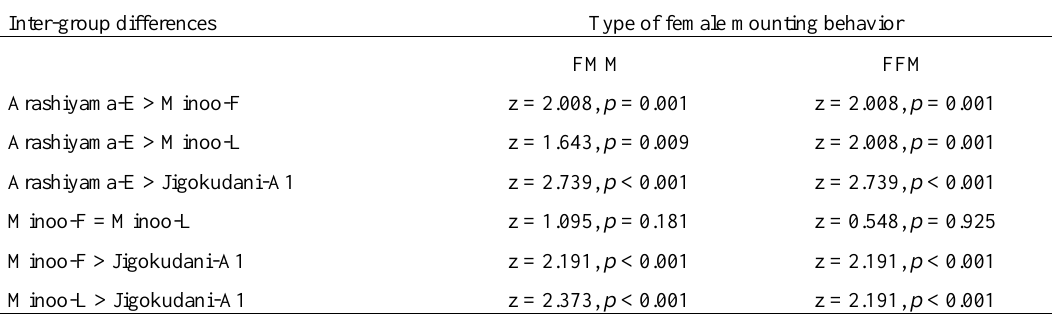
Inter-group Differences in the Weighted Cumulative Frequencies of FMM and FFM (two-tailed Kolmogorov-Smirnov tests) Inter-group differences Type of female mounting